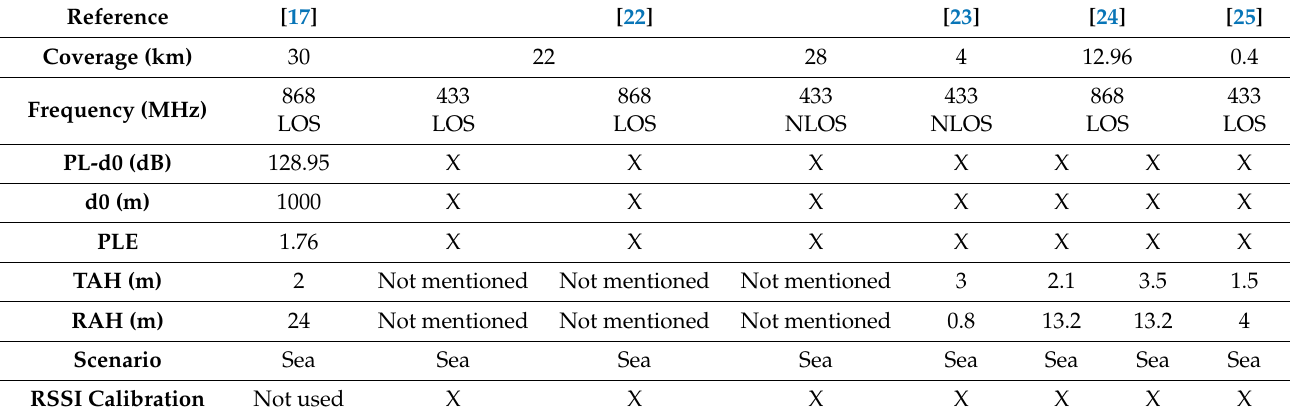
Table 1. Comparison of the propagation studies of the LoRa technology over